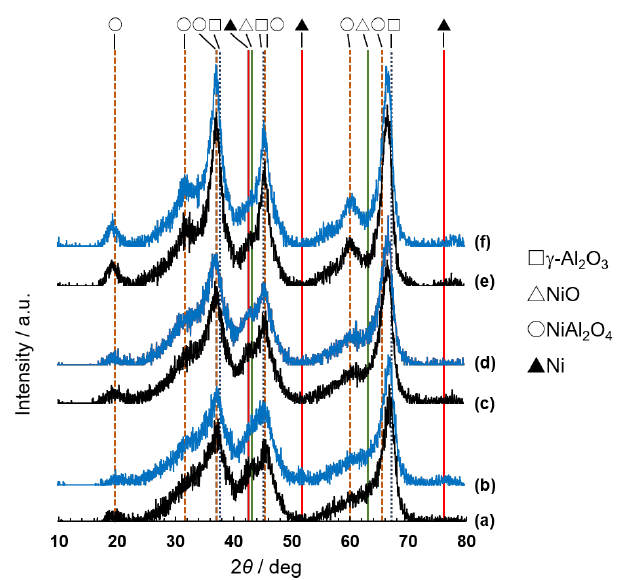
Figure 5. XRD patterns of 5Ni/Al 2 O 3 (KC, 773) ( a , b ), 5Ni/Al 2 O 3 (KC, 873) ( c , d ), and 5Ni/Al 2 O 3 (KC, 1073) ( e , f ) before (black) and after (blue) the plasma experiments shown in Figure 3. The diffraction lines could be assigned to γ-Al 2 O 3 (open square), NiO (open triangle), NiAl 2 O 4 (open circle), and metallic Ni particles (closed triangle).